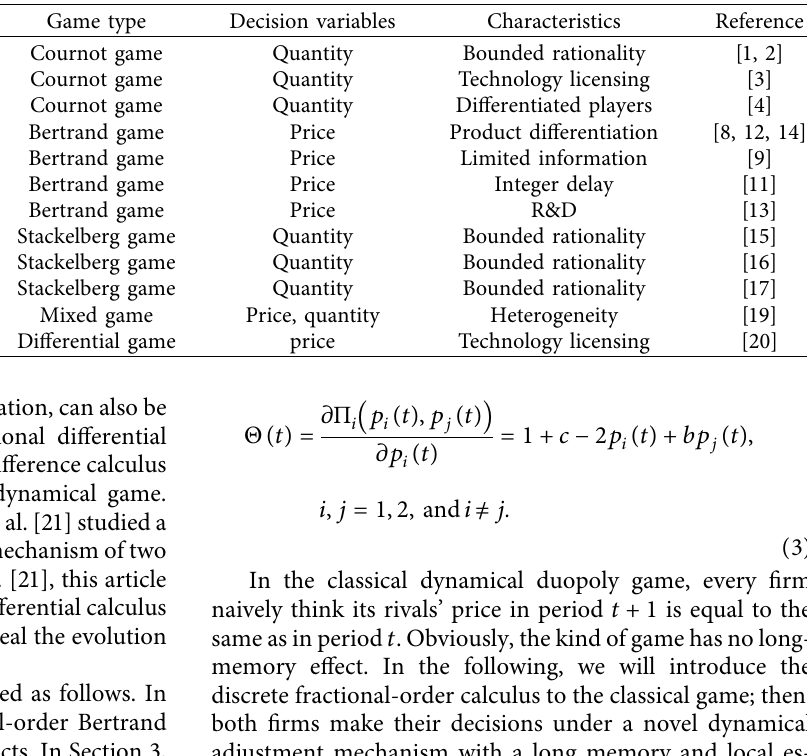
Table 1: Recent studies on dynamical duopoly games with integer-order difference